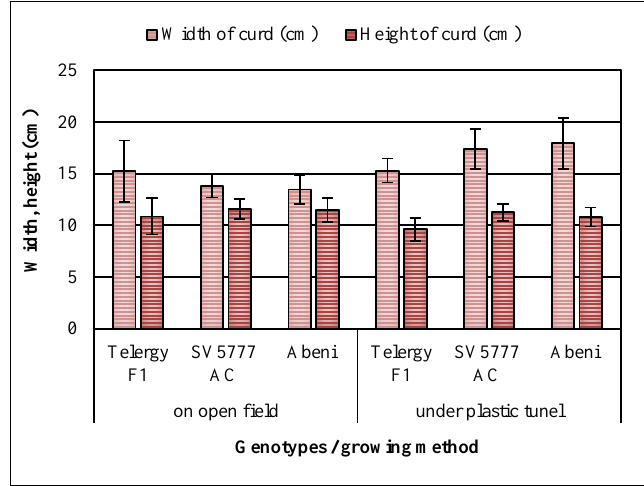
Figure 2 . The effect of different growing method on width and height of curds (n=10; Nagykereki, 2018)